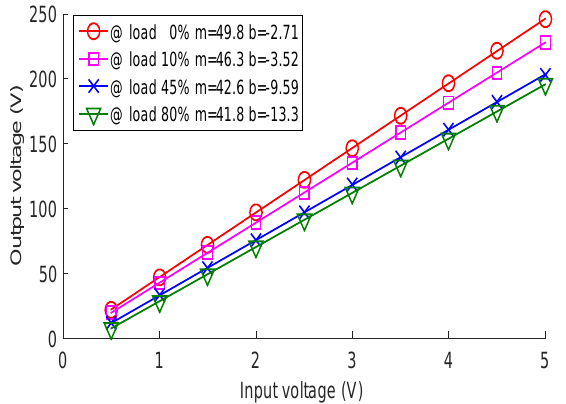
Figure 3. Variation of the output voltage of the HV DC converter device in relation to the input voltage and the connected load. VCA, variable control